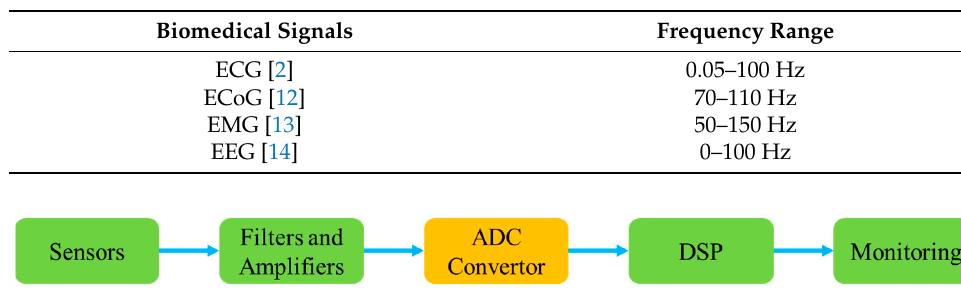
Table 1. Frequency ranges of various biomedical signals.